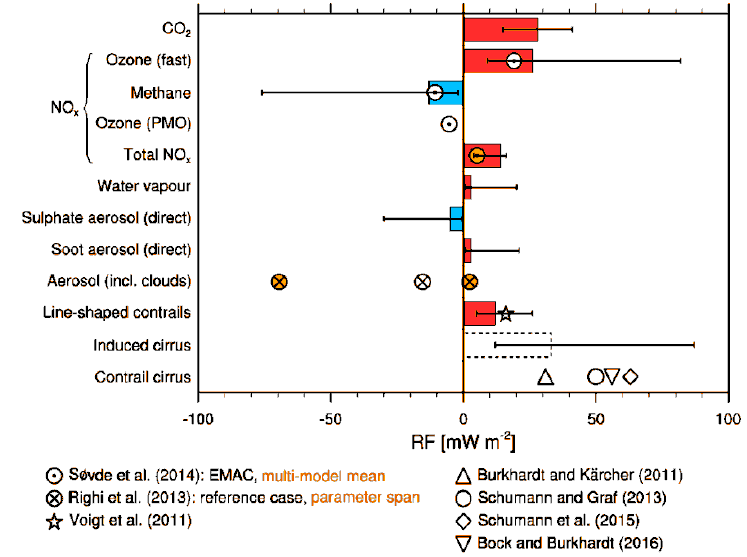
Figure 1. Aviation-induced radiative forcing from different components for the year 2005 [3–10].